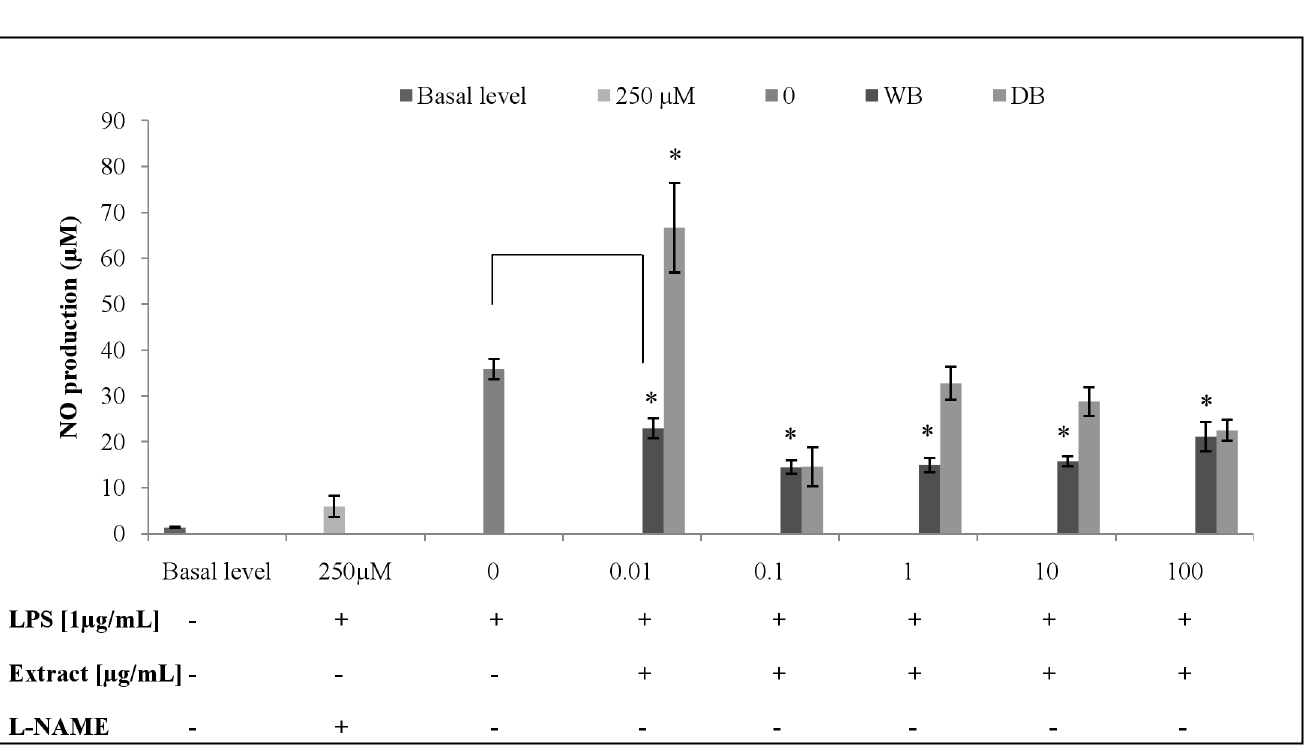
Fig 3. Effects of A . rugosum extracts on LPS-induced NO production by RAW264.7 cells (S1 Dataset). RAW264.7 cells were co-incubated with various concentrations of A . rugosum extracts and 1 μ g/mL LPS for 24 hrs. L-NAME (250 μ M) served as the positive control. Results shown represent the mean ± SD, n = 3 and * p < 0.05 versus LPS-induced NO level alone.